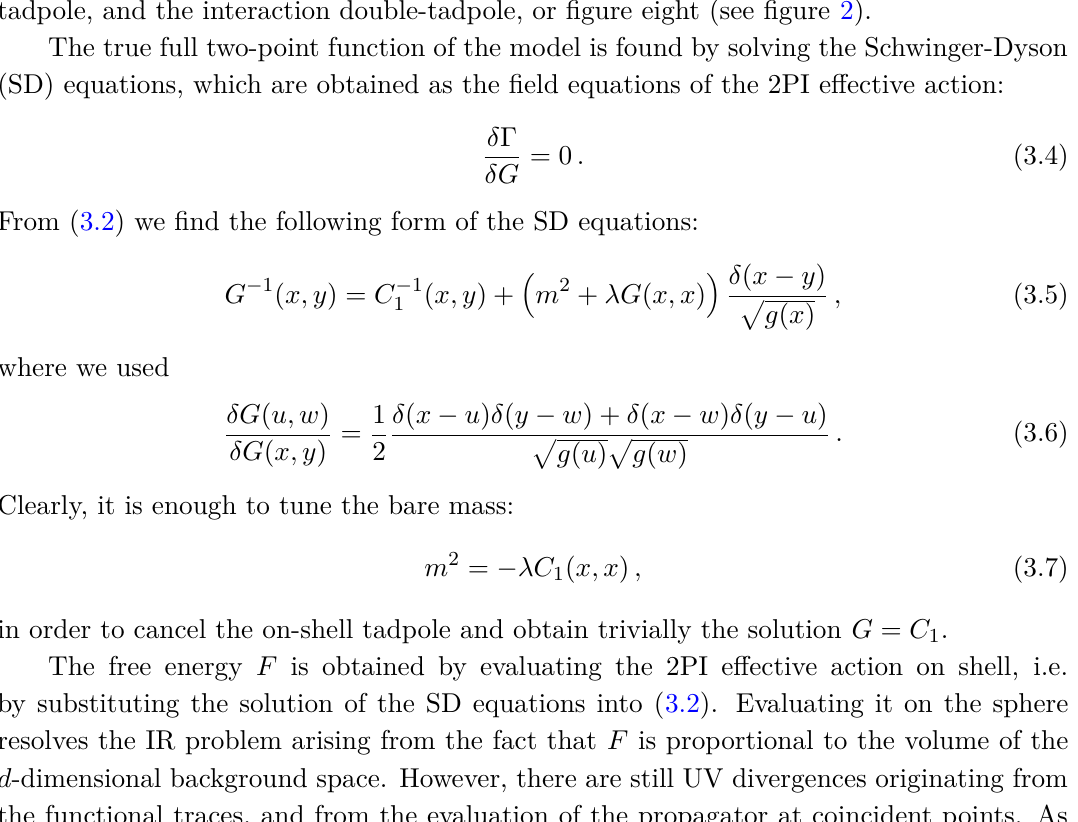
), or by a formal expansion 1